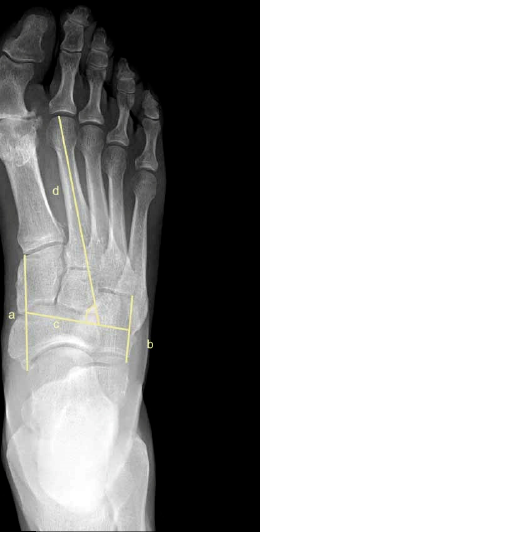
Figure 9. Dorsoplantar weightbearing radiograph of modified Kilmartin’s angle. Simons’ angle [37], Figure 10, is the angle between a perpendicular line (b) of the articular surface of the talar head (longitudinal axis of the talus) line (a) and the longitudinal axis of the 1st metatarsal, line (c).